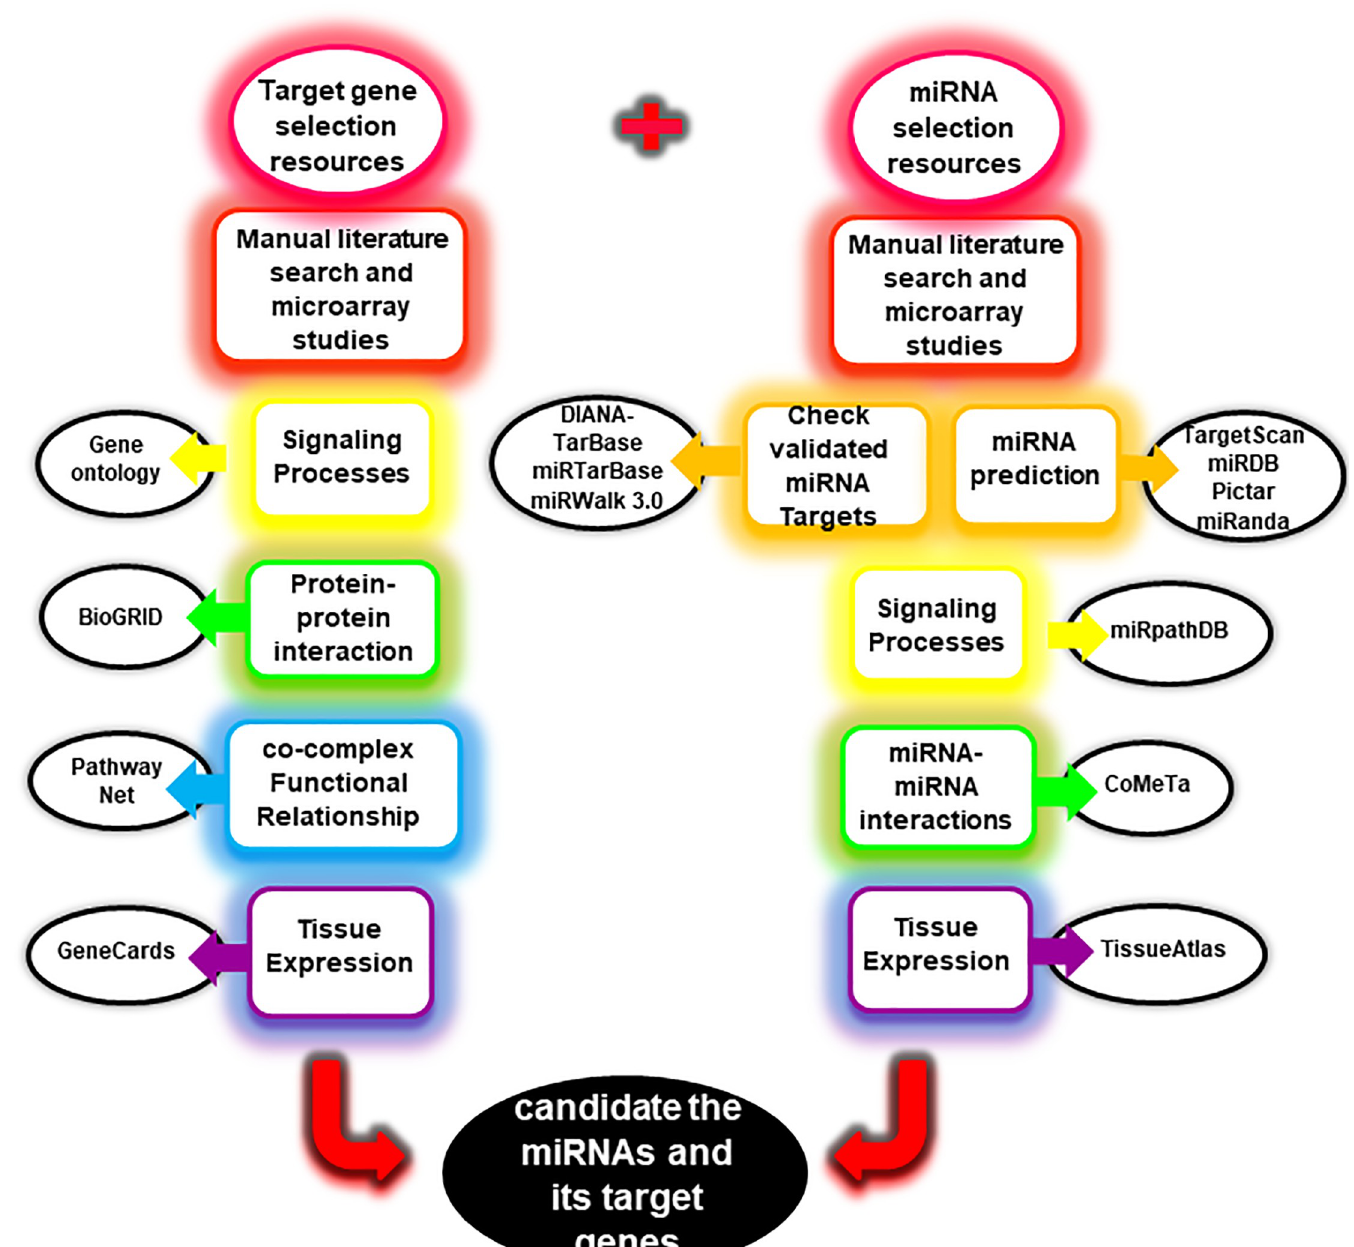
Fig 1. The resources for the selection of miRNAs and target gene. The general principles for selective resources of the miRNA-target gene are presented in the flowchart. Several databases and websites were used in-silico analysis of miRNAs and target gene. The names of databases and websites are displayed in non-colored elliptical forms. Details are mentioned in the text. The results of the in-silico analysis are presented in S1 Fig.